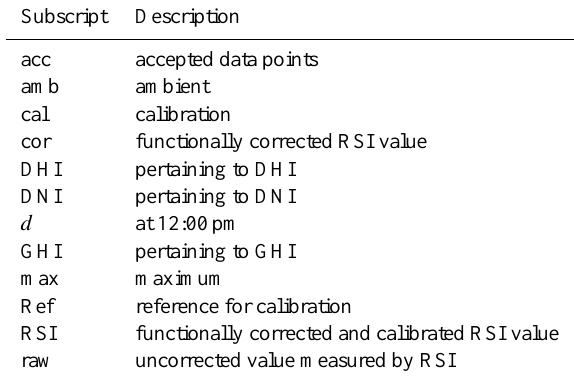
Table 2. Subscript